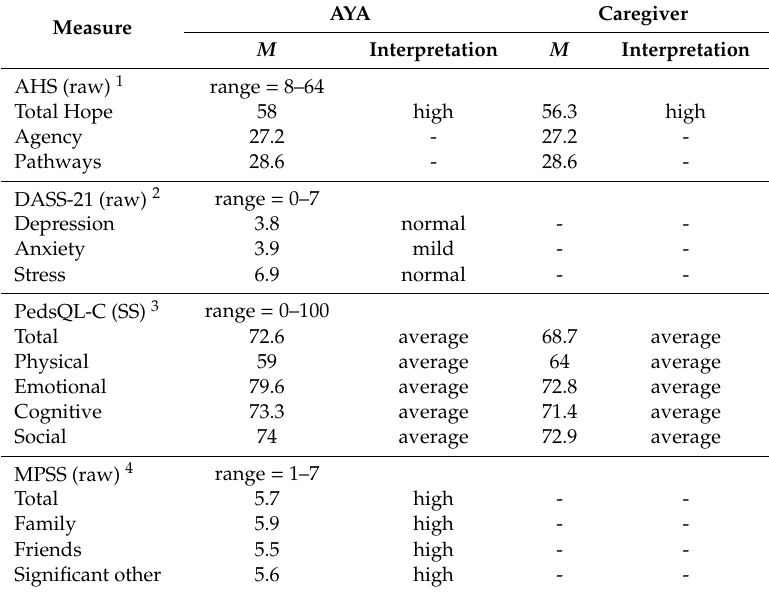
Table 2. Results from descriptive